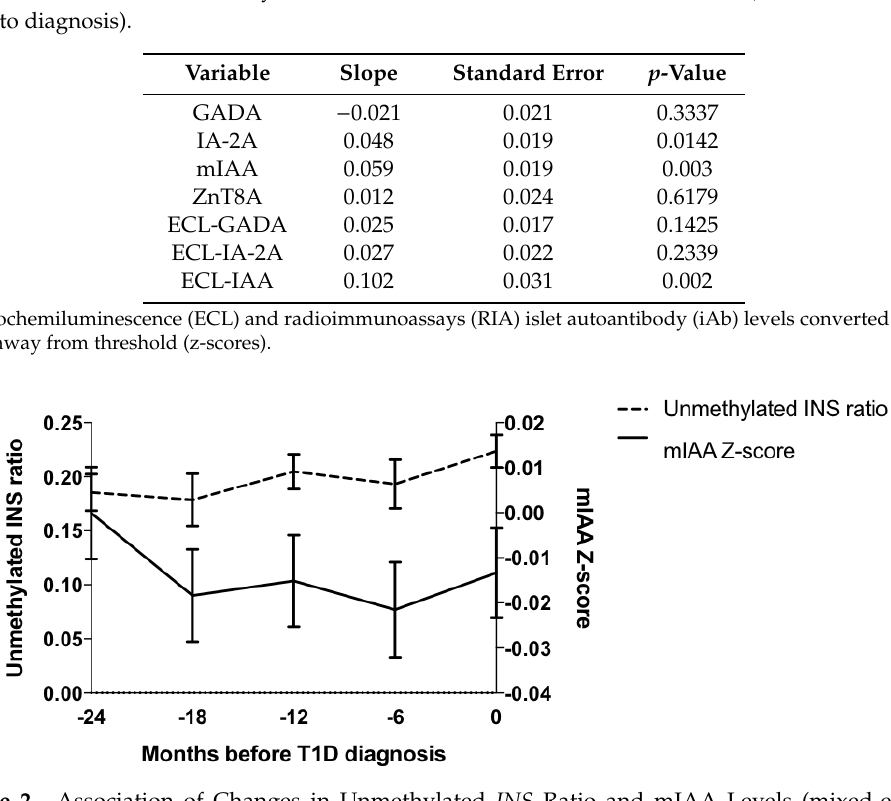
Figure 2. Association of Changes in Unmethylated INS Ratio and mIAA Levels (mixed-effects longitudinal models). mIAA levels were significantly associated with unmethylated INS ratios over time, with a 0.24 change in the ratio for each 0.1 change in the mIAA z-score ( p = 0.02).